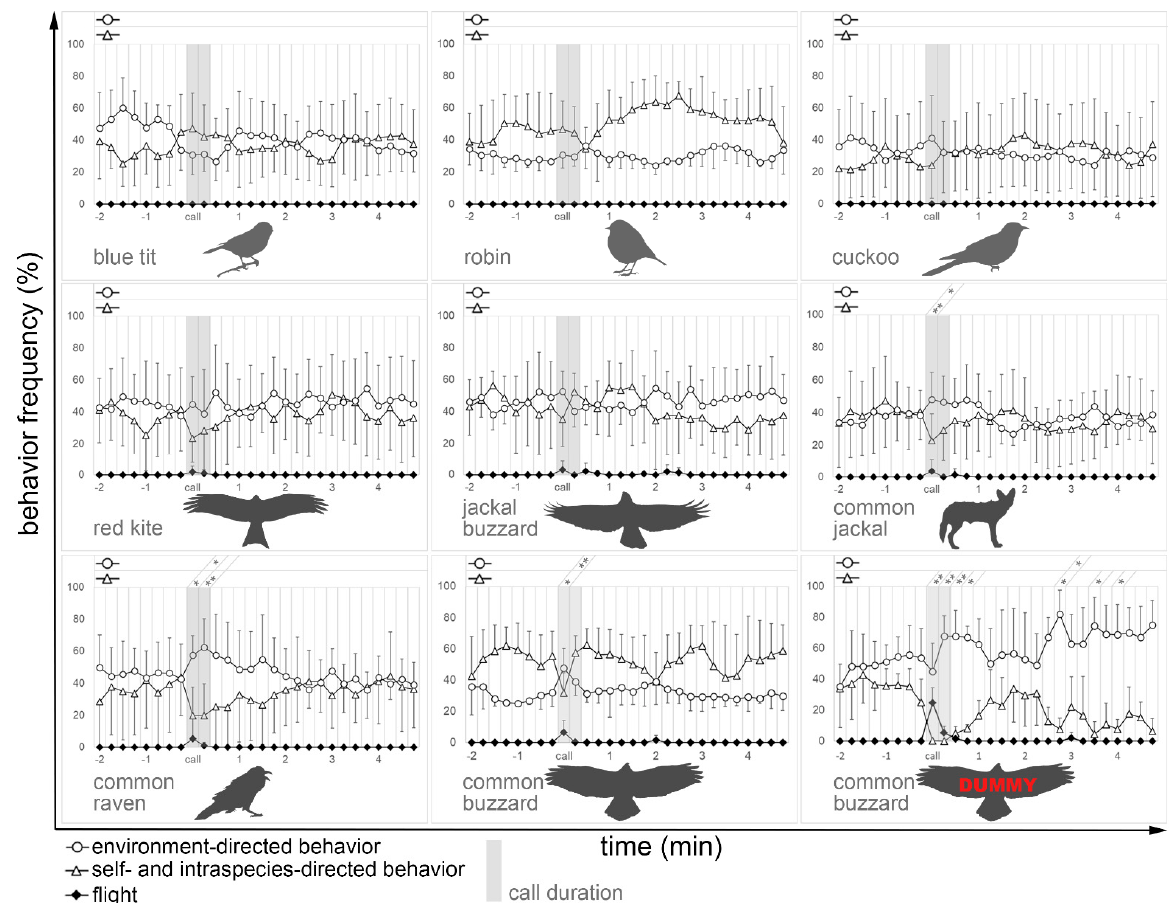
Figure 2. The figure shows how the self- and intraspecies-directed, the environment-directed, and the flight behavior evolve for the different stimuli. The time axis is divided into 15 s intervals. Each interval shows how frequently the associated behavior was observed (in %). The gray shaded area marks the period in which the stimulus was presented. If present, a significant difference between one interval and the mean of the eight intervals before stimulus onset for self- and intraspecies-directed behavior and environment-directed behavior can be taken from the upper part of each graph. Only significant differences are shown: (*) p ≤ 0.05; (**) p ≤ 0.01.